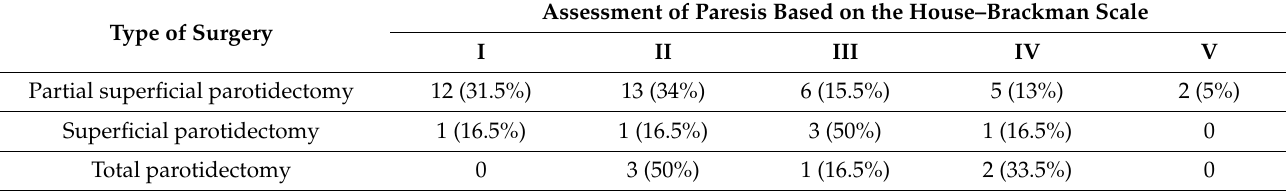
Table 2. Transient facial nerve paresis depending on type of